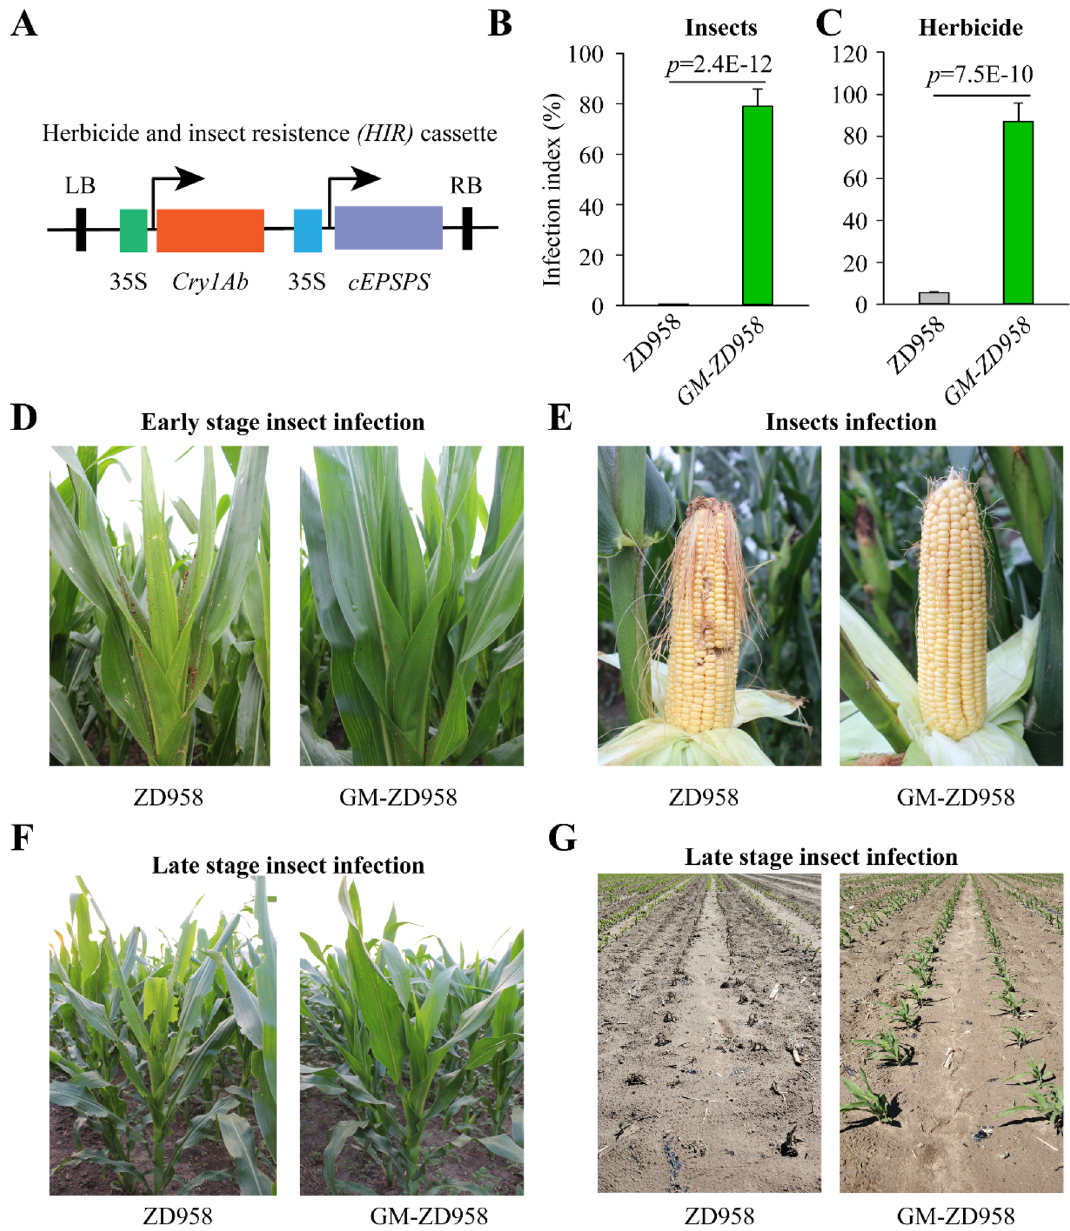
Figure 2. Field performance of herbicides and insect resistance of ZD958 expressing HIR gene cassette in gene- modification (GM)-ZD958 maize lines grown in Beijing field (E116.3°, N39.7°), China. ( A ), Schematic map of constructed vector for HIR gene cassette. ( B , C ), Comparison of infection index to insect ( Bacillus thuringiensis ) and herbicide (glyphosate) resistance in GM-ZD958 from two transgenic events, compared to non-GM ZD958. ( D , E ), Field imaging of GM-ZD958 and non-GM ZD958 exposed naturally to insect in canopy in early stage ( D ) and maize seeds during silking stage ( E ). ( F , G ), Field imaging of GM-ZD958 and non-GM ZD958 exposed naturally to insect in canopy in late stage ( F ) and performance of non-GM ZD958 and GM-ZD958 subjected to glyphosate